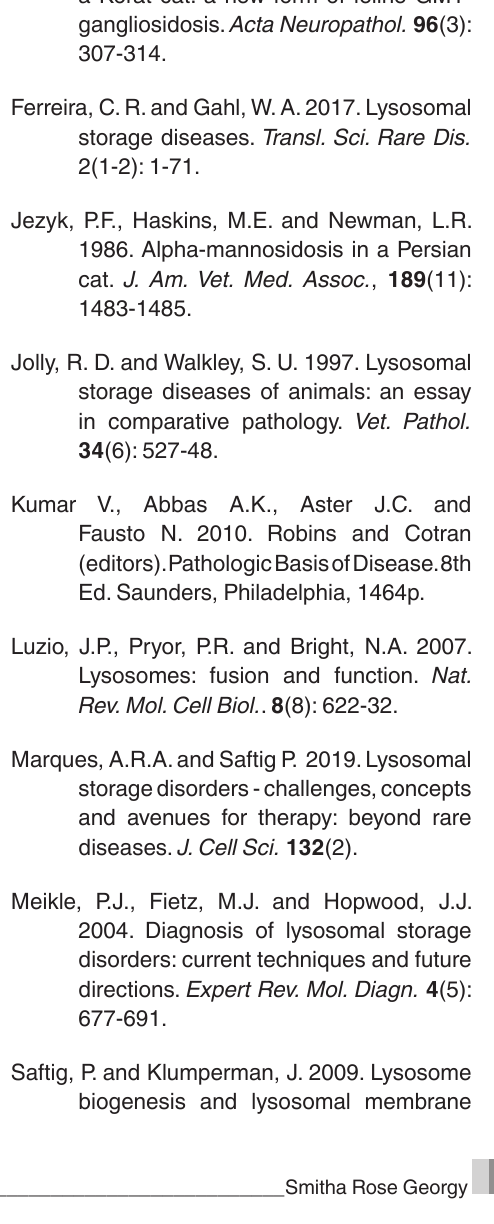
Fig 2: Accumulation of storage material in cerebellar neuron